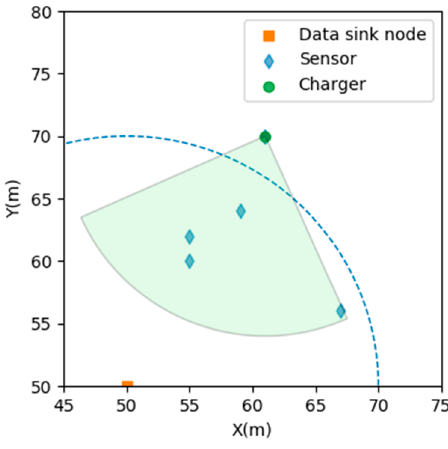
Figure 2. Covers all sensors with one charger.